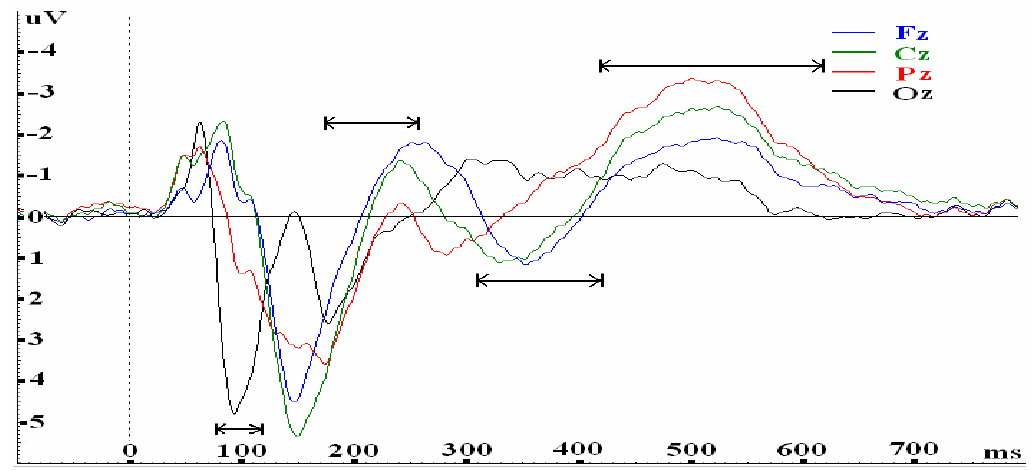
Figure 3. Averaged ERP curves of 16 subjects recorded from the mid line